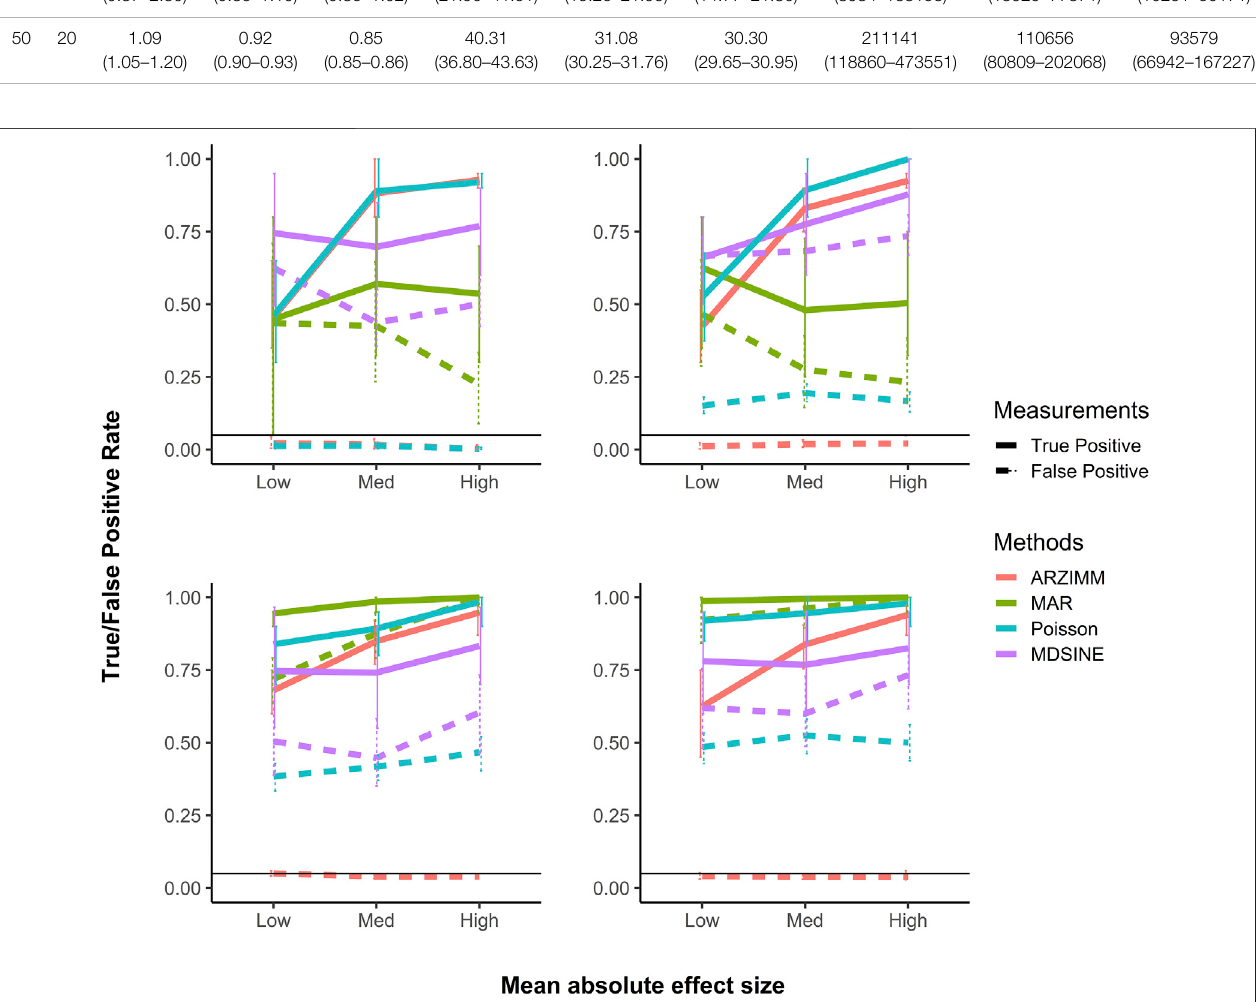
FIGURE 3 | Simulation results of variable selection performance. Poisson refers to the penalized Poisson auto-regression model and MAR refers to penalized log- normal multivariate auto-regression model. MDSINE refers to the method with extended generalized Lotka-Volterra (gLV) equations using a Bayesian algorithm. Mean (and 95% con fi dence interval) of false positive and true positive rates are reported for 500 simulations with 50 subjects and 20 time points in four scenario: (A) no zero- in fl atedstructure and noheterogeneity, (B) heterogeneitybutno zero-in fl atedstructure, (C) zero-in fl atedstructure but noheterogeneity, and (D) both zero-in fl ated structure and